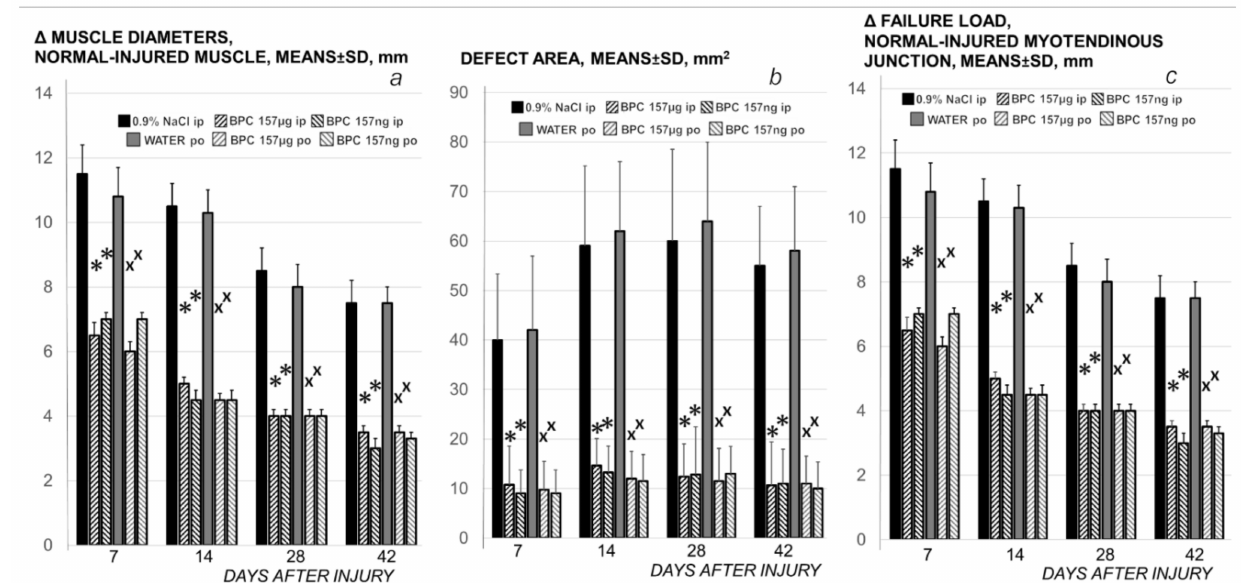
Figure 7. Rats with the disabled myotendinous junction, muscle diameters (as ∆ between normal and injured muscle) ( a ); defect area, mm 2 ( b ), and biomechanics ( c ) assessment, means ± SD at 1, 3, 5, 7, 10, 14, 21, 28 and 42 days. Assessments were macroscopic (the area of the defect resulting from the separation of the tendon and muscle fibers, mm 2 ), microscopic (normal-injured muscle diameters, mm); tensiometry (special device Lineomat, MLW Medizinische Geräte, Chemnitz, Germany, mm, means ± SD), performed in accordance with our muscle and tendon injuries studies [19–22,31,35–37,47]. Medication (BPC 157 (10 µ g/kg, 10 ng/kg)) was applied either intraperitoneally (BPC 157 µ g ip; BPC 157 ng ip), first application immediately after surgery, last 24 h before sacrifice, or perorally in drinking water (0.16 µ g/mL, 0.16 ng/mL, 12 mL/rat/day) (BPC 157 µ g po; BPC 157 ng po) while controls received either saline (5 mL/kg), intraperitoneally or drinking water (12 mL/rat/day) till the sacrifice, at 7, 14, 28 and 42 postoperative days.* p < 0.05, at least, vs. control (ip); x p < 0.05, at least, vs. control (po).